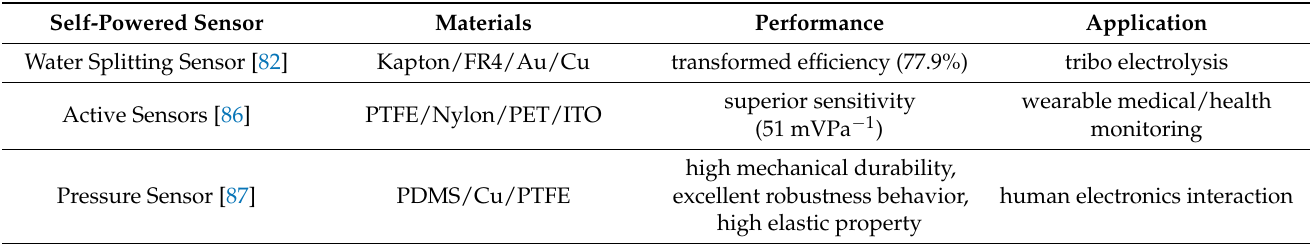
Table 1. Comparison of various self-powered